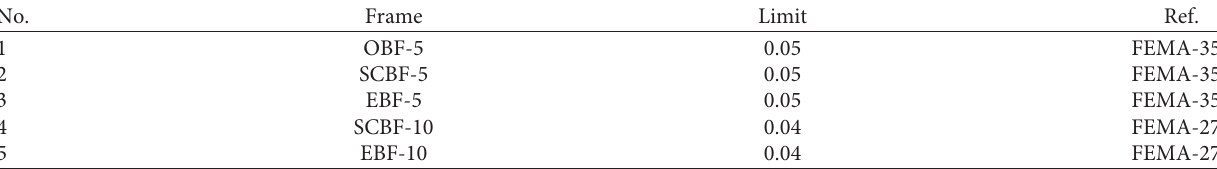
Table 9: Drift limit of collapse prevention for various structural systems.